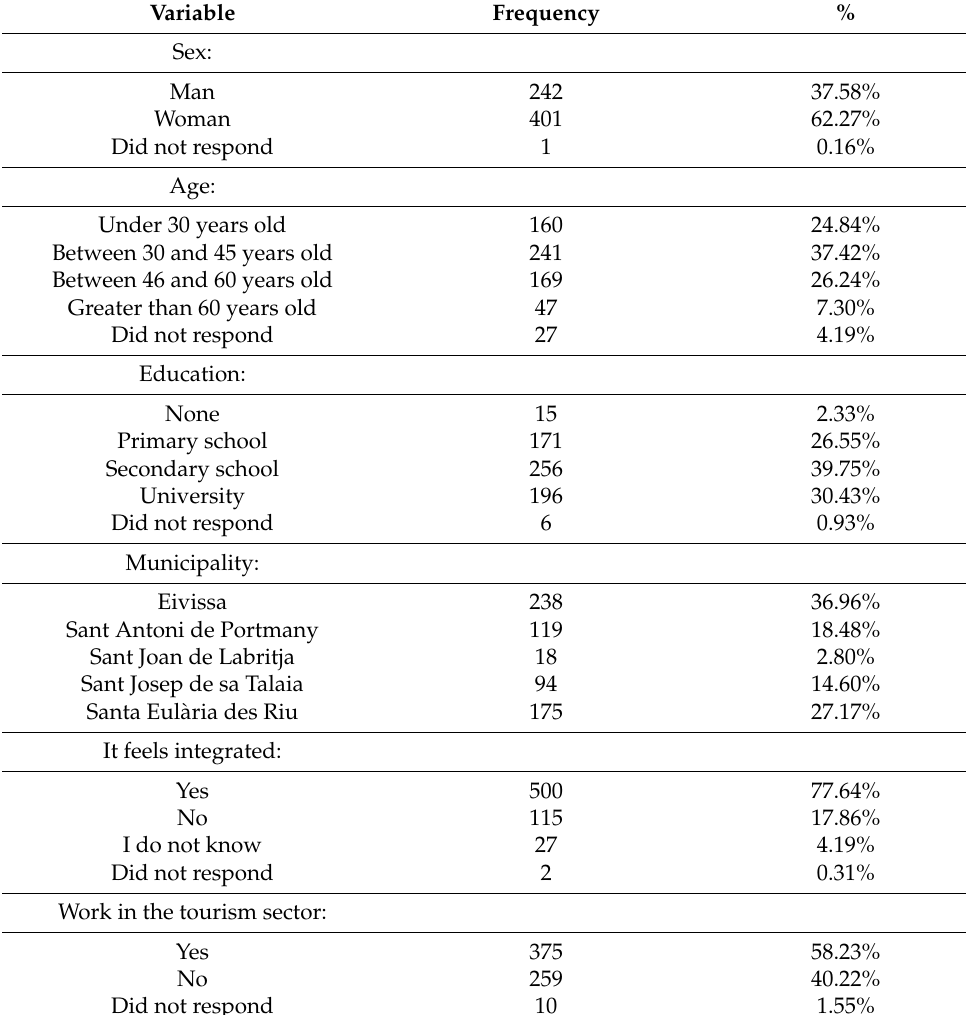
Table 2. Sociodemographic profile of the sample (own